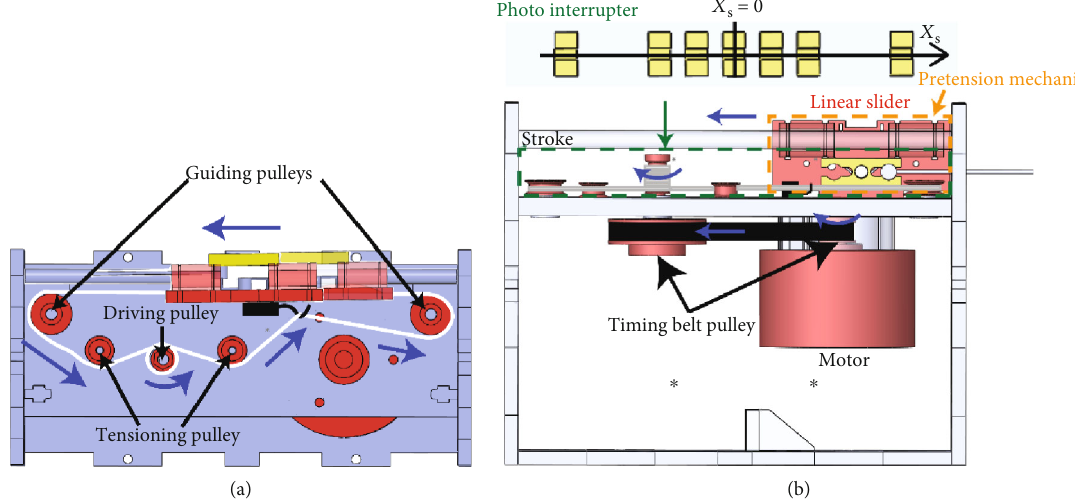
Figure 7: Illustration of the power transmission based on the slider and the pulley system in the (a) top and (b) side